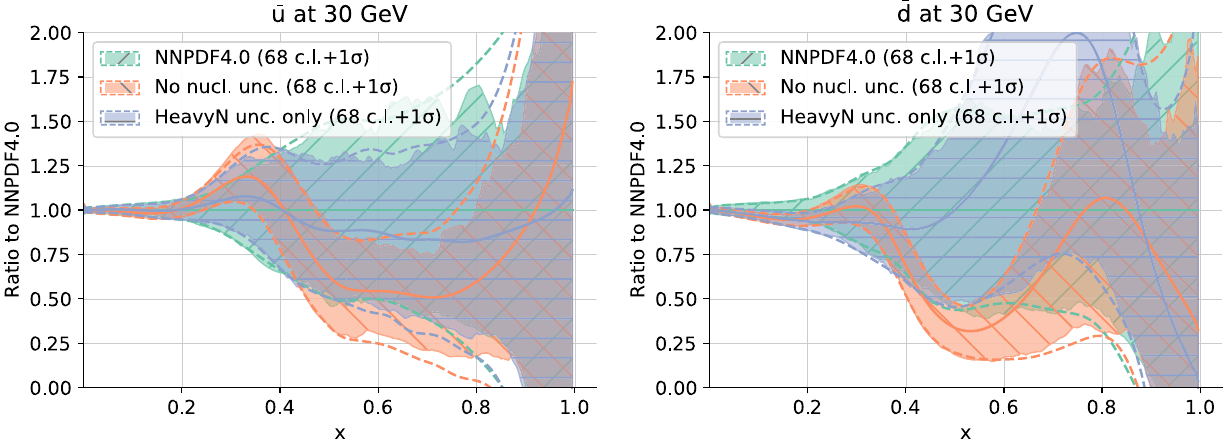
Fig. 54 The antiup and antidown PDFs at Q = 30 GeV from the “No nucl. unc.” and “HeavyN unc.” PDF sets of Table 31 compared to the